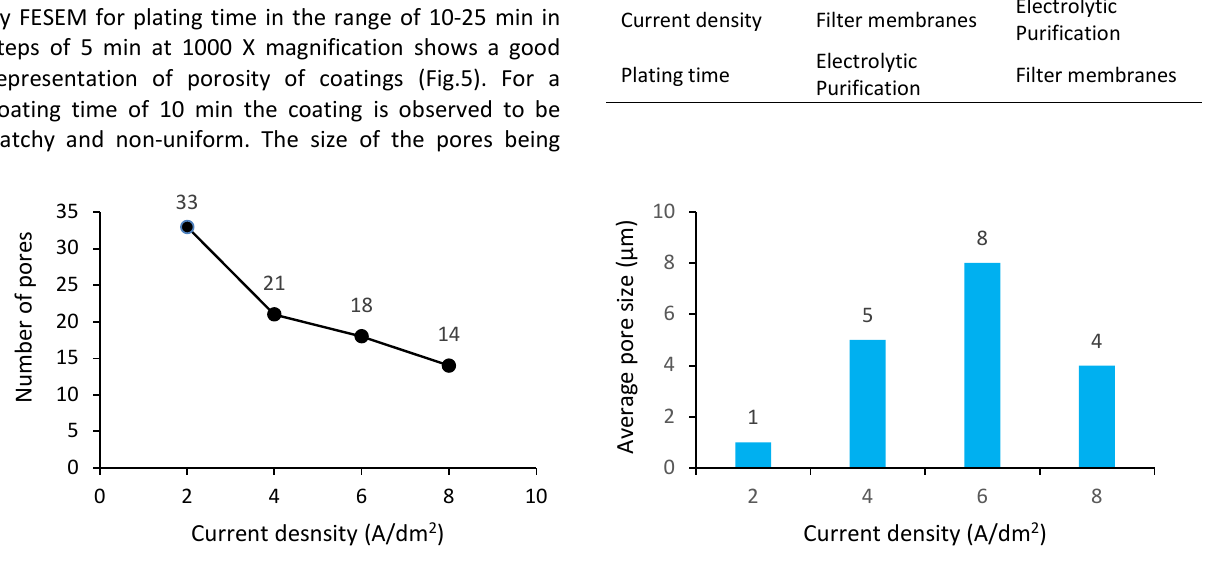
Fig.4 . Variation in number of pores and Size of the largest pore with current